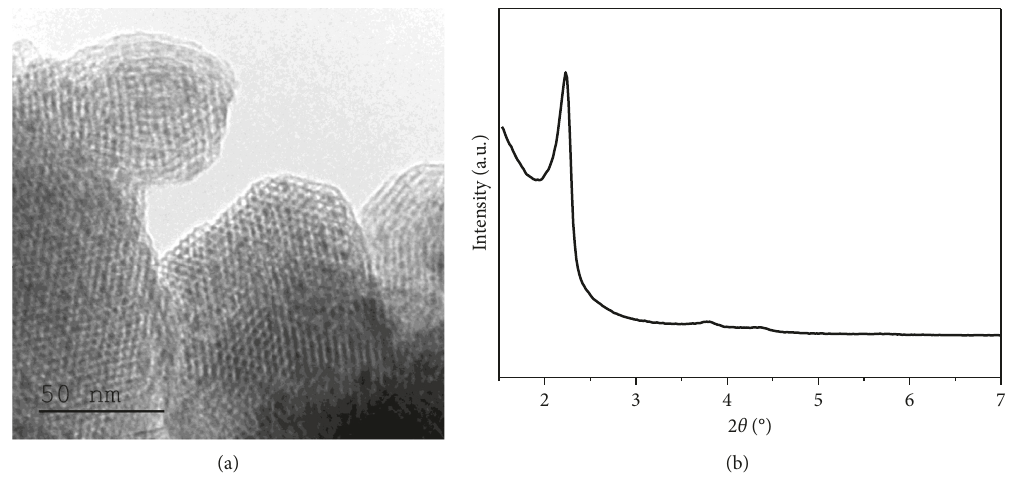
Figure 8: (a) TEM image of MnLUS SSI and (b) XRD pattern of MnLUS Imp after the catalytic